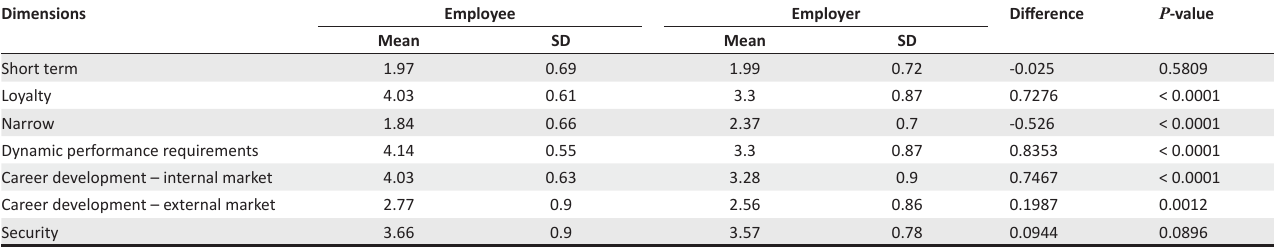
TABLE 5: Paired t -test at a significance level of 5 % .